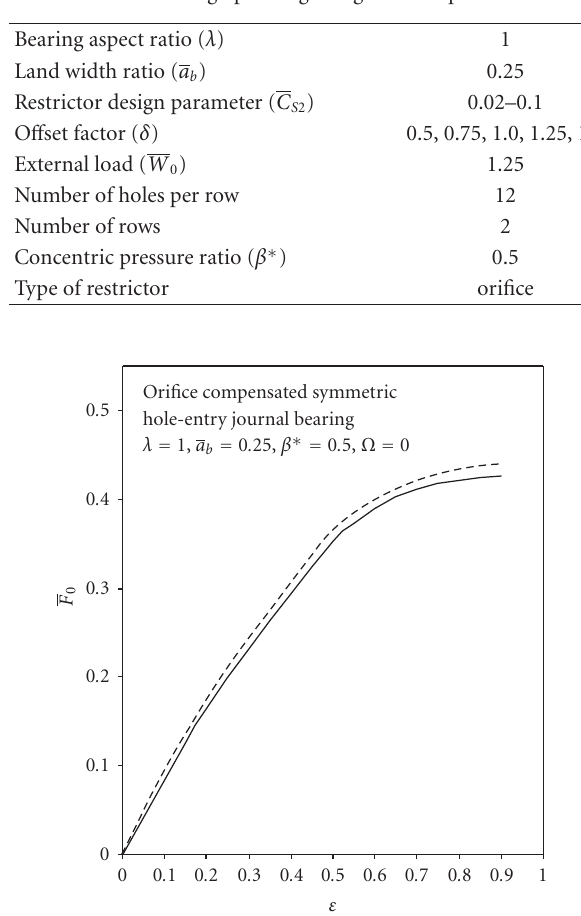
Figure 2: Overall iterative scheme.